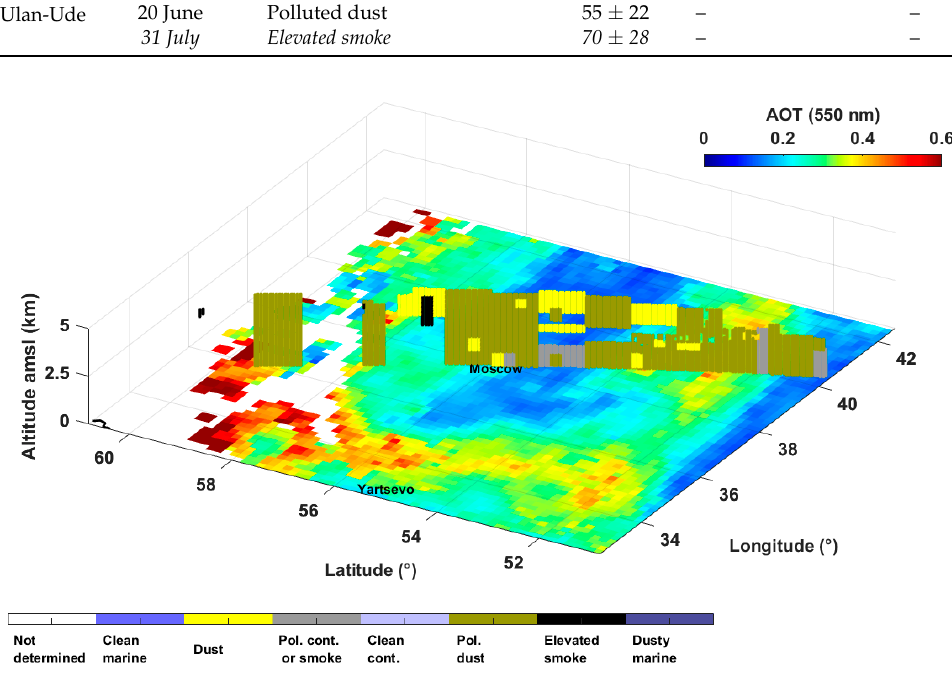
Figure 10. Aerosol classification along CALIOP orbit track passing above Moscow around 10:20 UTC (14:20 LT) on 11 August 2013, plotted above a map of MODIS 550 nm AOT on the same morning.